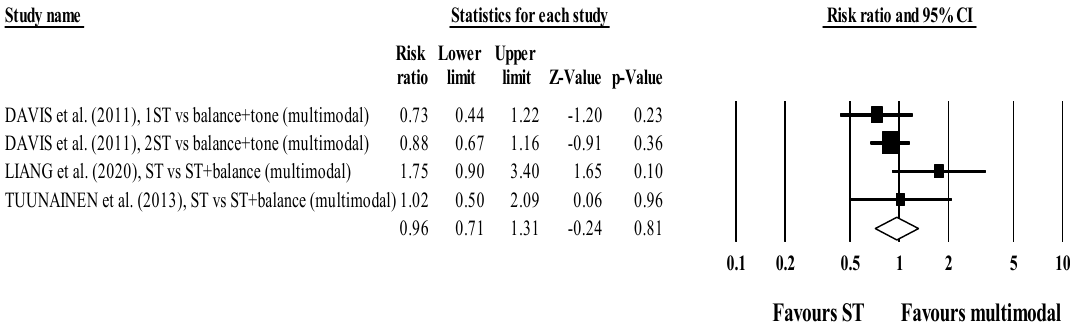
Figure 4. Forest plot for risk of falling after participating in ST programs compared to multimodal active control conditions.